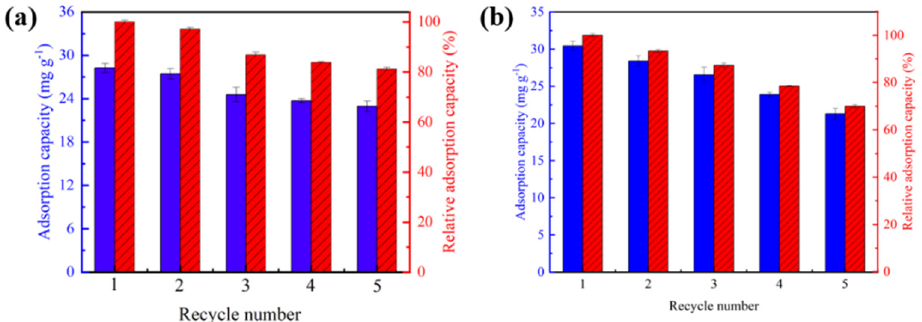
Figure 10. ( a ) Cyclic adsorption/desorption performance of the HTO/CA. ( b ) Cyclic adsorption/desorption performance of the HTO powder (pH = 10.25, V = 160 mL, m ≅ 100 mg, C 0 = [Li + ] = 50 mg L − 1 ).